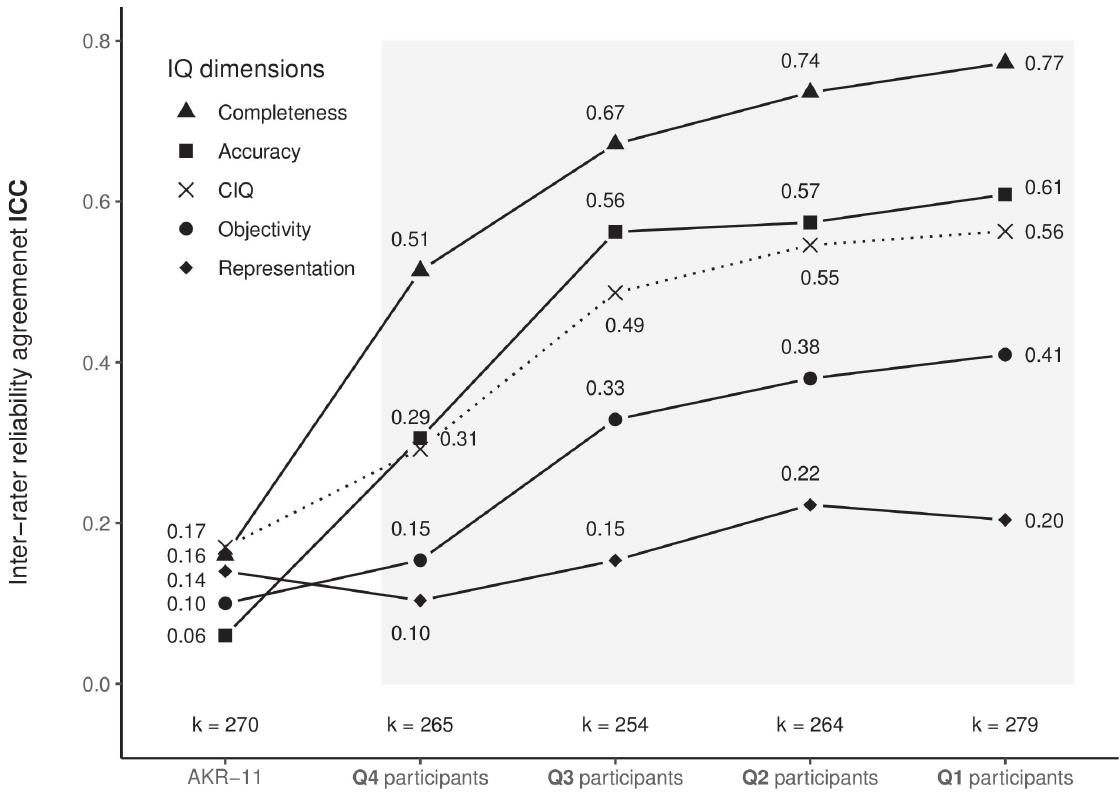
Fig 3. Interclass correlation vs. performance of players. The y-axis represents the ICC, while the x-axis portrays four groups of participants. The groups are divided into quartiles according to the points that participants scored when performing the gamified process. The first column AKR-11 contains results of a similar IQ study, in which [2] studied the measurability of IQ on the same set of IQ dimensions used in our study. The four highlighted columns (rightmost) exhibit the results of our study, where each column represents one group of